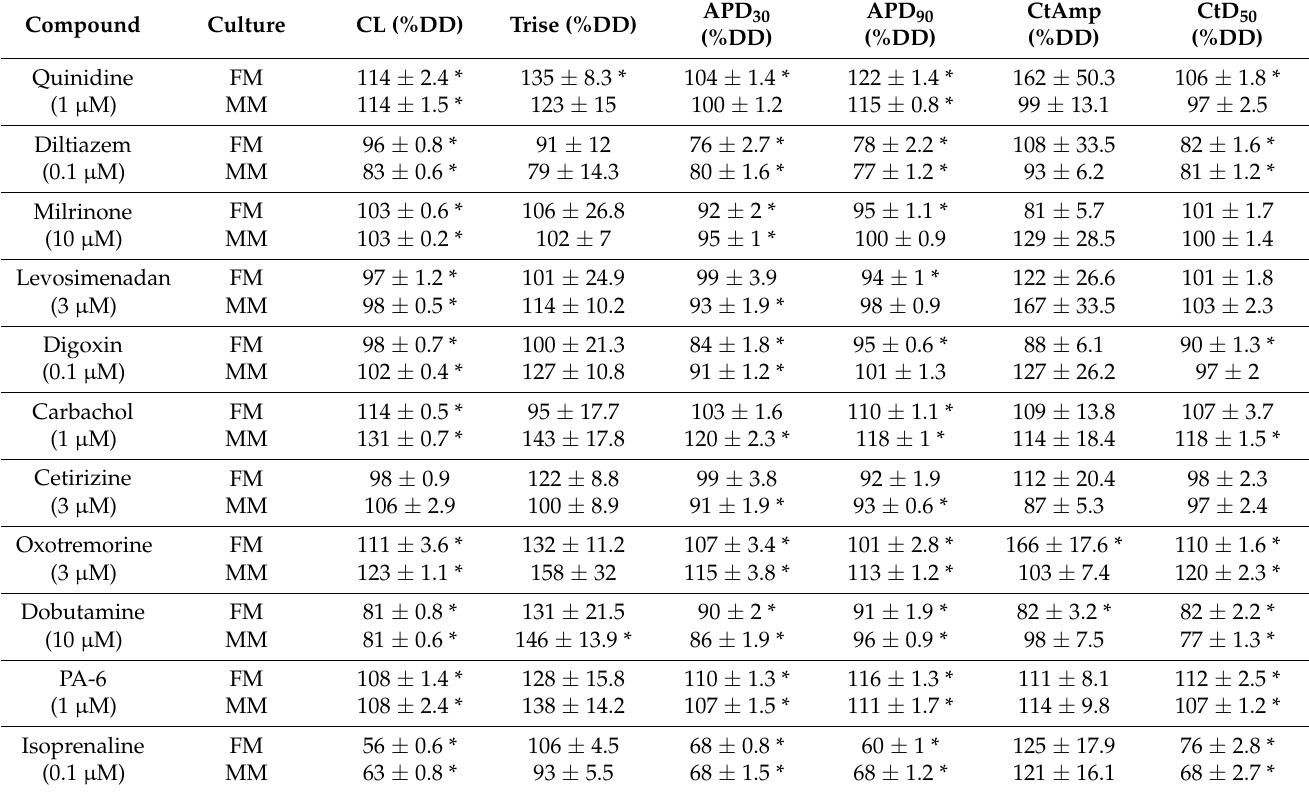
Table 2. Overview of the effect of the different compounds at specific concentrations on the relevant parameters of the two models. The data are expressed as mean ± SEM. FM monolayer represents the fibronectin matrix, and the MM monolayer represents the MatrixPlus. * p < 0.05 vs. 0.1% DMSO